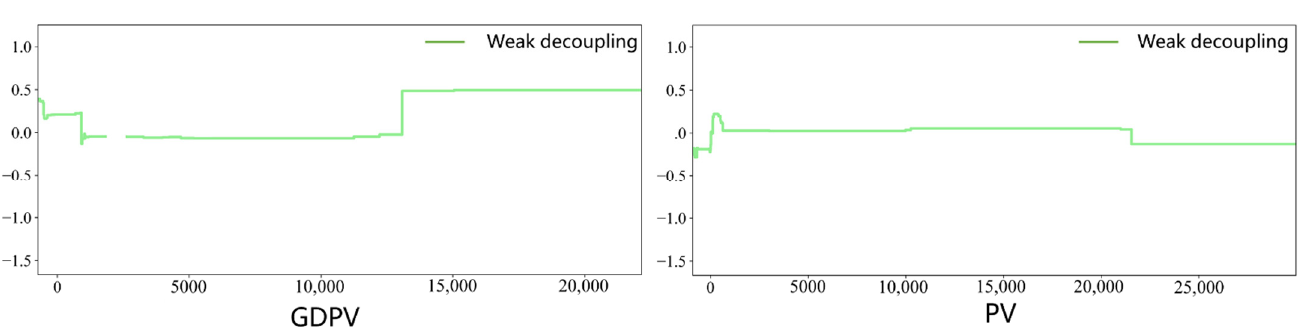
Figure 9. MC-EBM results between top five key variables and matching modes (C1: SD, C2: WED, C3: RWD, C4: SND).